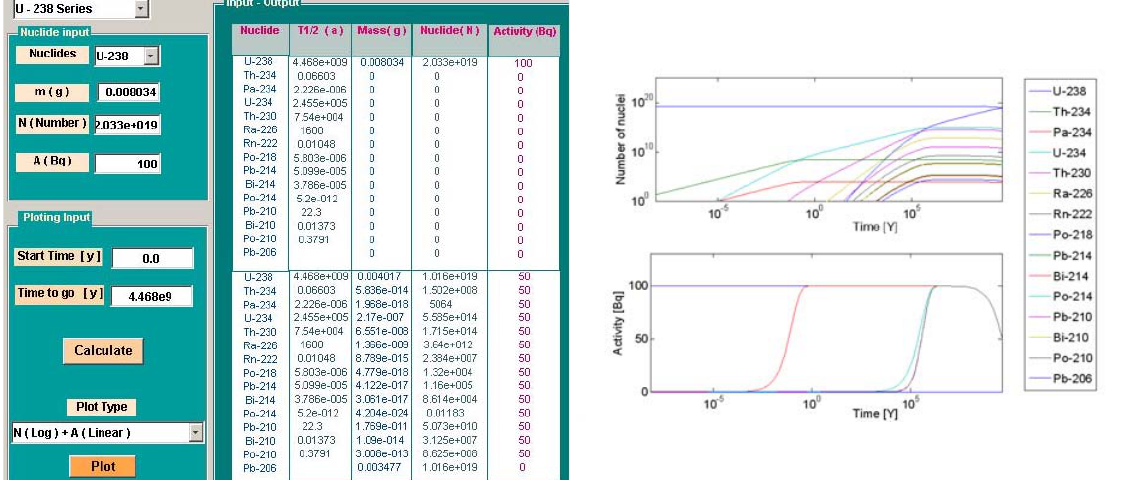
Fig. 2 Structure of DECSERVIS operation interface (left). Interface consists of input and output options (see text). Output can be seen as numerical (lower table) and graphical forms. An operation example for 238 U decay chain is given: nuclide is 238 U, its activity 100 Bq and decay time (time to go) is equal to the half-life of 238